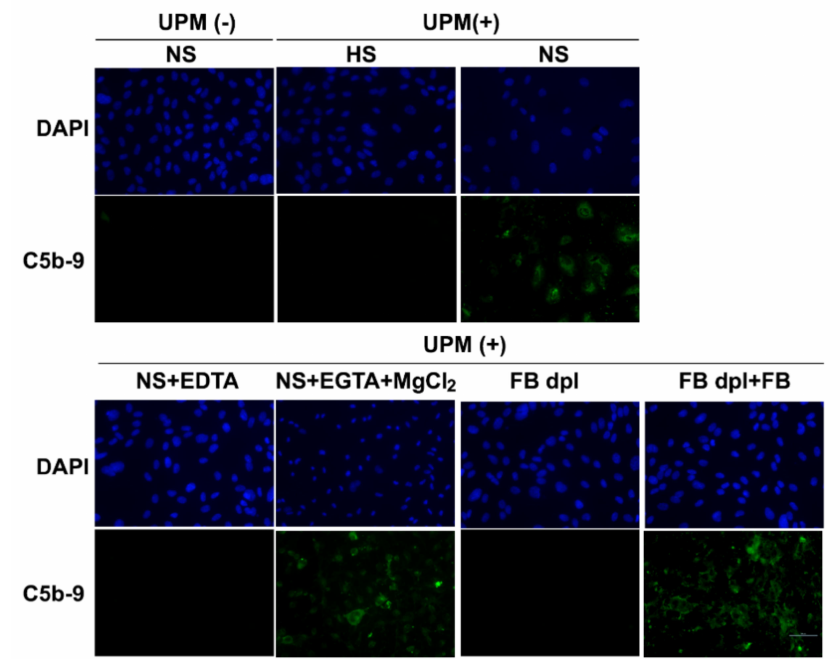
Figure 2. Activation of the alternative pathway of the complement system in UPM-treated HUVECs. Untreated or UPM-treated HUVECs were incubated with heated human serum or normal human serum. Then, 20 mM EDTA and 10 mM EGTA with 20 mM MgCl 2 were used to inhibit the entire pathway and the classical pathway of the complement system, respectively. Factor B-depleted serum (FB Dpl sera), or Factor B (FB) was used to investigate whether the alternative pathway was activated in UPM-treated HUVECs. Nuclei were stained with DAPI (blue), C5b-9: deposition of C5b-9 (green). Scale bar: 50 µ